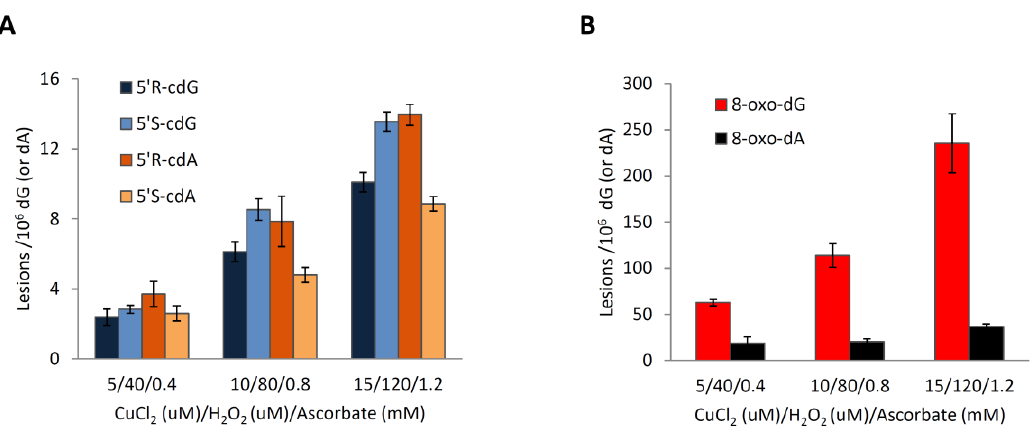
Figure 12. CuCl 2 /H 2 O 2 /Ascorbate-induced formation of ( A ) 5′ R -cdG, 5′ S -cdG, 5′ R -cdA and 5′ S -cdA and ( B ) 8-oxo-dG and 8-oxo-dA in ds-ODNs. The numbers represent the mean value (±standard deviation) of n = 3 independent experiments.